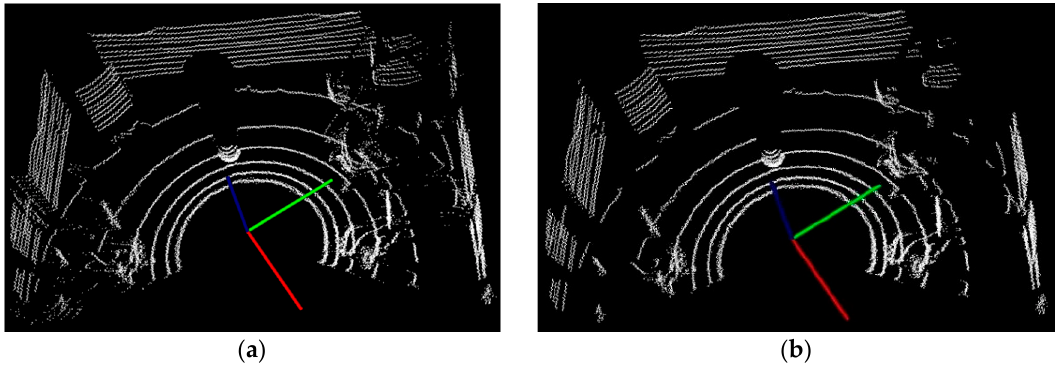
Figure 3. The results of outliers and noise filtering: ( a ) Before filtering; ( b ) After filtering.